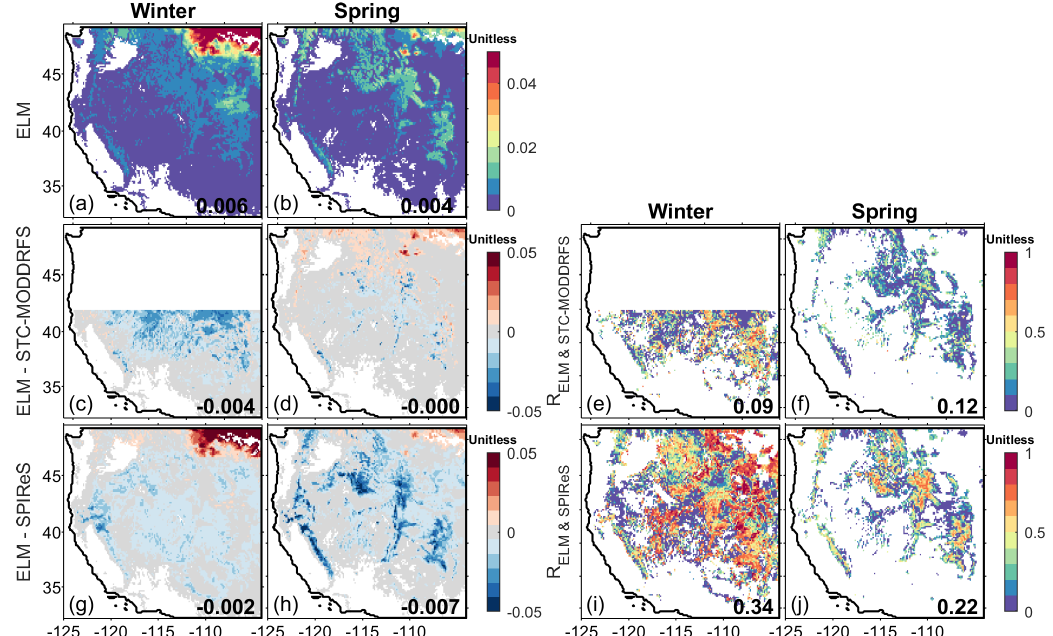
Figure 11. Spatial distributions of (a, b) snow albedo reduction ( R sno ) in ELM, and (c, d, g, h) the R sno difference between ELM and two remote sensing products (i.e., STC-MODDRFS and SPIReS) and (e, f, i, j) their temporal correlations (Rs) for different seasons: (a, c, e, g, i) winter and (b, d, f, h, j) spring. In all panels, regions with no snow cover are masked with white color. The area-weighted average values are labeled in each